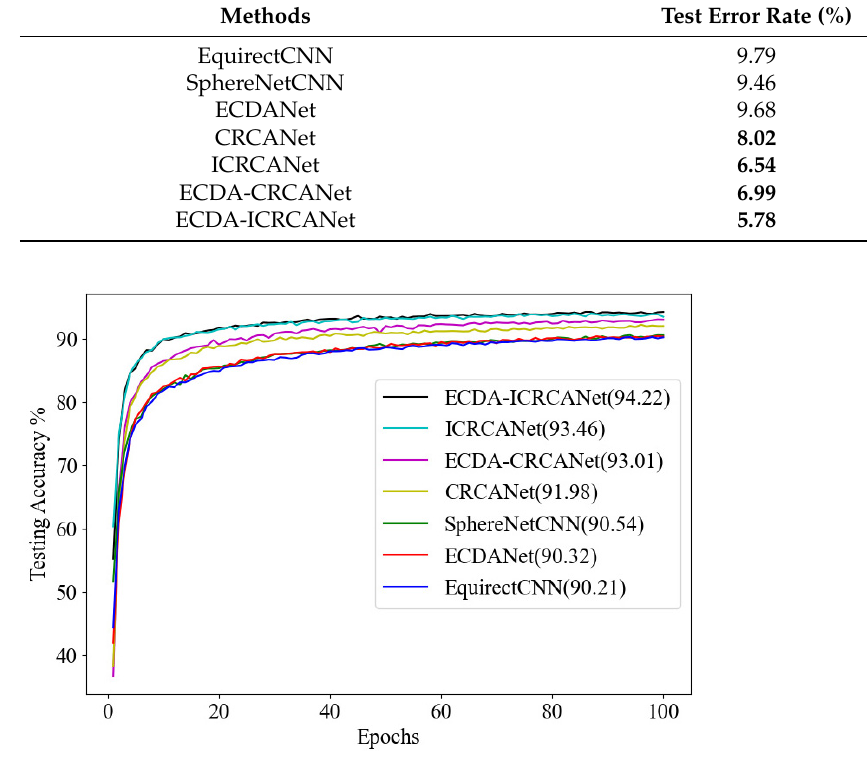
Figure 8. Changes in test accuracy during